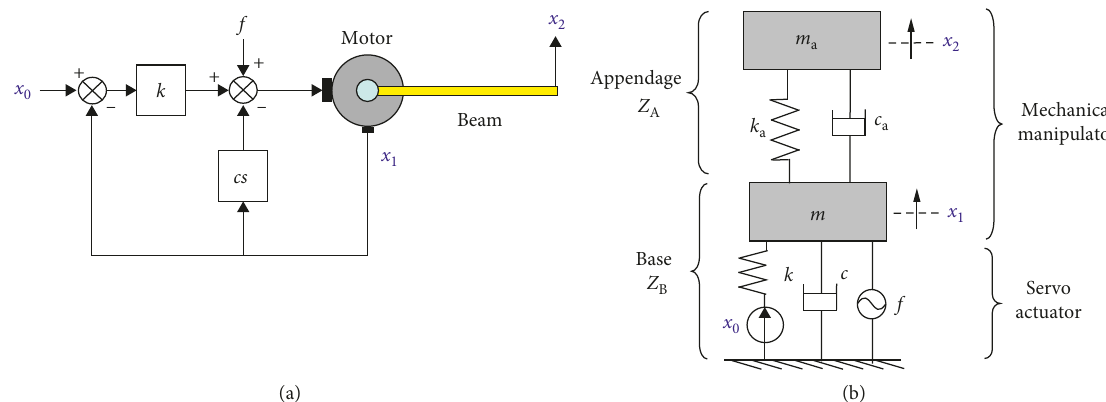
Figure 1: PD control of a flexible manipulator with the proportional gain k and the derivative gain c (a) and the equivalent two-body LES (b): x 0 is the command input position, x 1 is the hub position, and x 2 is the tip